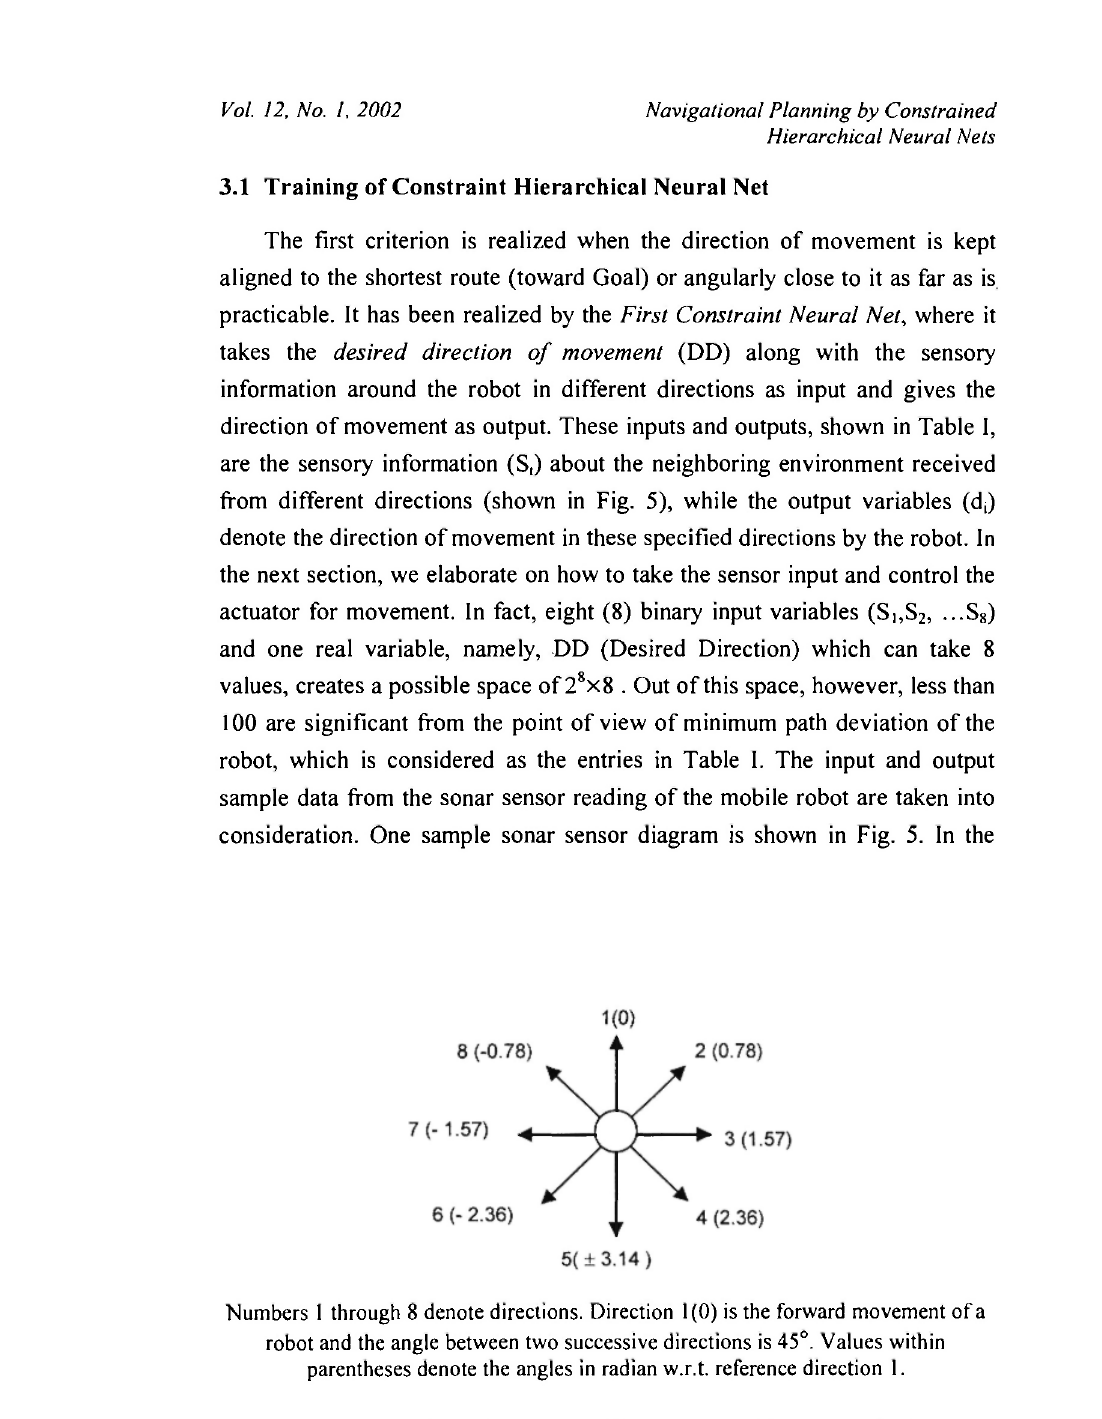
Fig. 5: Directions of movement of Robot estimated in angle